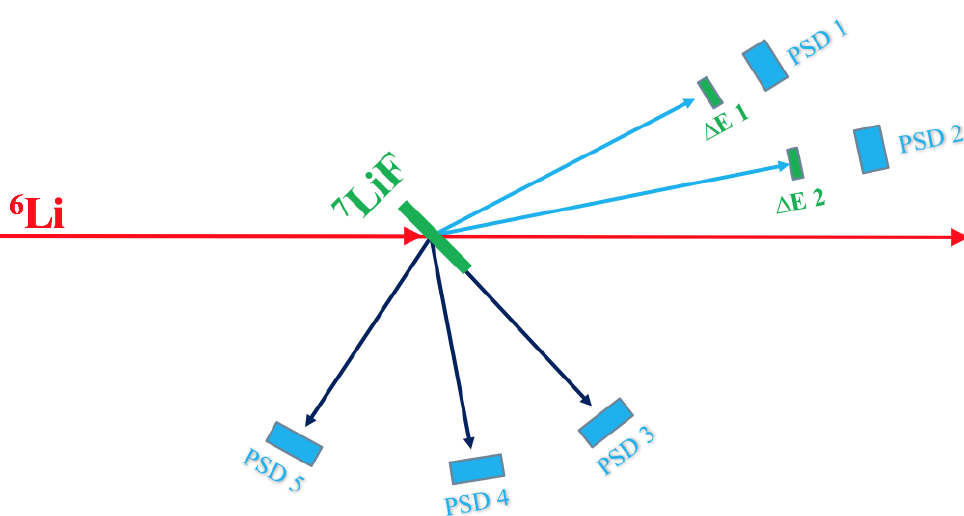
composed by two ∆ E-E telescopes (placed at 12.3 ◦ 7 ◦ and 32.3 ◦ 7 ◦ ) made up using thin silicon ± ± detectors (82 mm 2 active surface, 15 µ m and 9 µ m thickness respectively) as ∆ E stage and thick (500 µ m each) Position Sensitive Detectors (PSDs) as E stage, both meant for deuteron particles detection. On the opposite side of the beam, another 3 PSDs with the same specifics are placed at 12 ◦ , 81 ◦ 9 ◦ and 119.9 ◦ 11 ◦ and are devoted to proton detection (Fig. 1). The necessity to 37.7 ◦ ± ± ± have detectors sensible to the position is given by the fact that one of the three particles in the exit channel of the 6 Li( 19 F,p 22 Ne)d, in this case 22 Ne, is not experimentally detected, but its characteristics are reconstructed form the energies and positions of the two measured